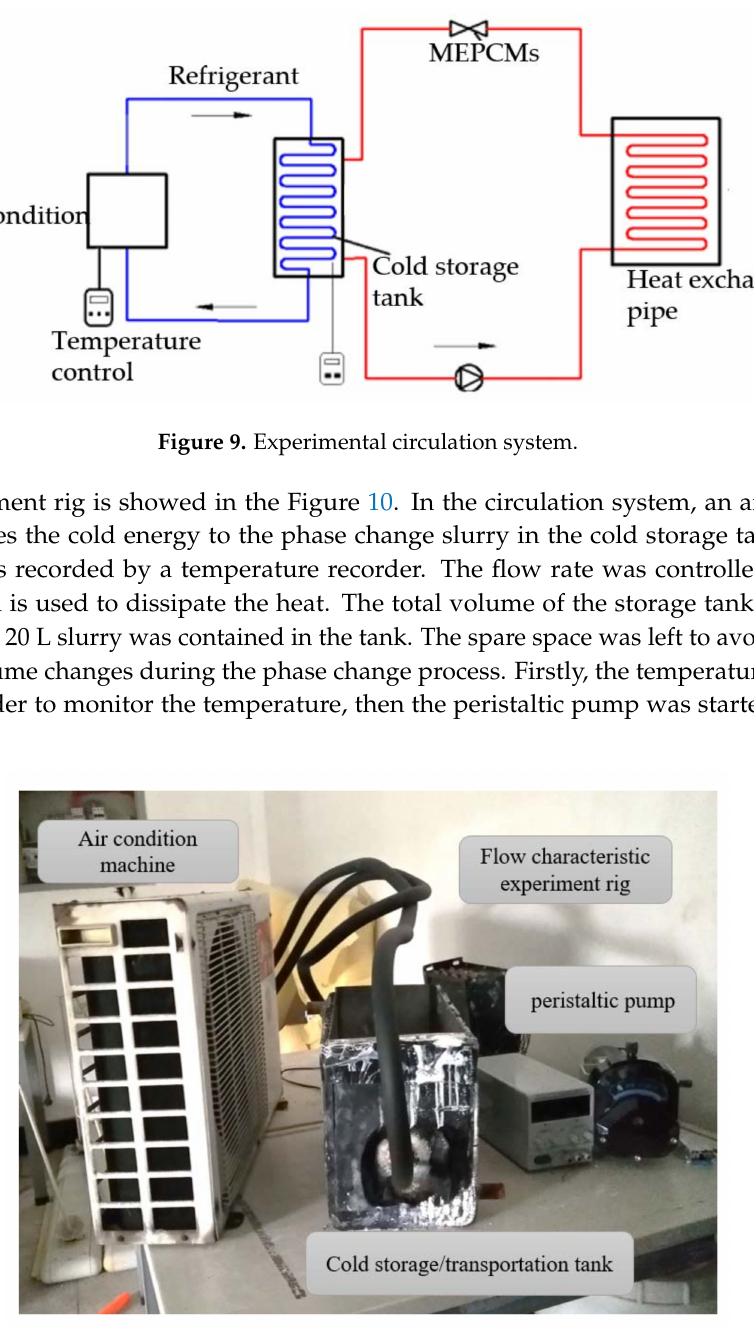
Figure 10. The flow characteristics experiment